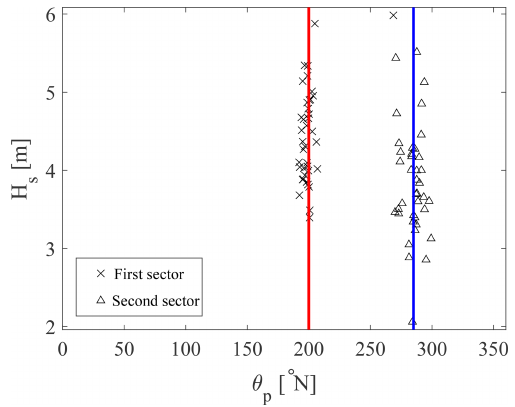
Figure 7. Directions of the extreme waves belonging to the two considered sectors.